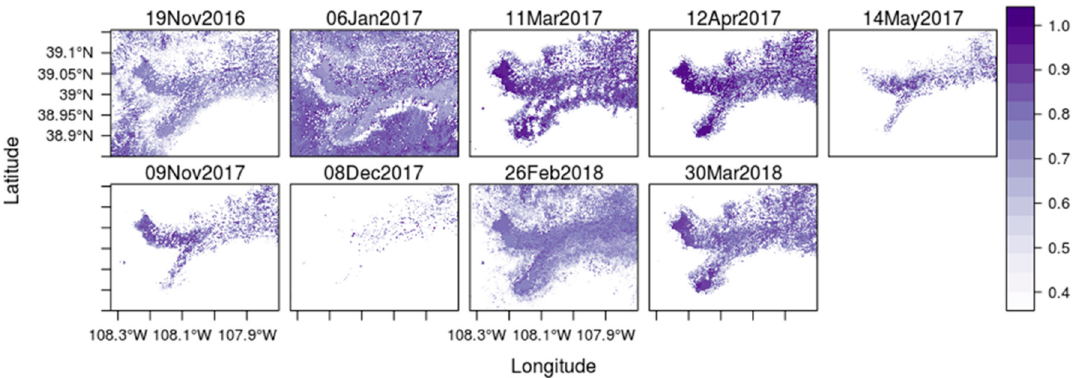
Figure 4. Snow-covered area (SCA, 2016–19), Grand Mesa, CO from Landsat-8 data (cloud free days) at 30 m resolution. White areas indicate snow-free conditions; light to dark colors represent NDSI values from low (0.4: some snow present) to high (1: snow covered pixel).